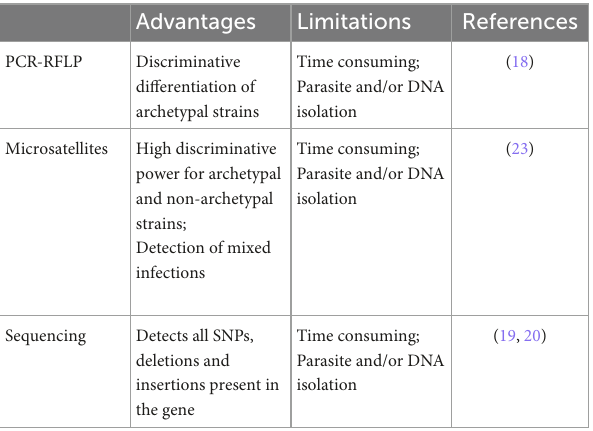
TABLE 1 Advantages and limitations of genotyping methods.